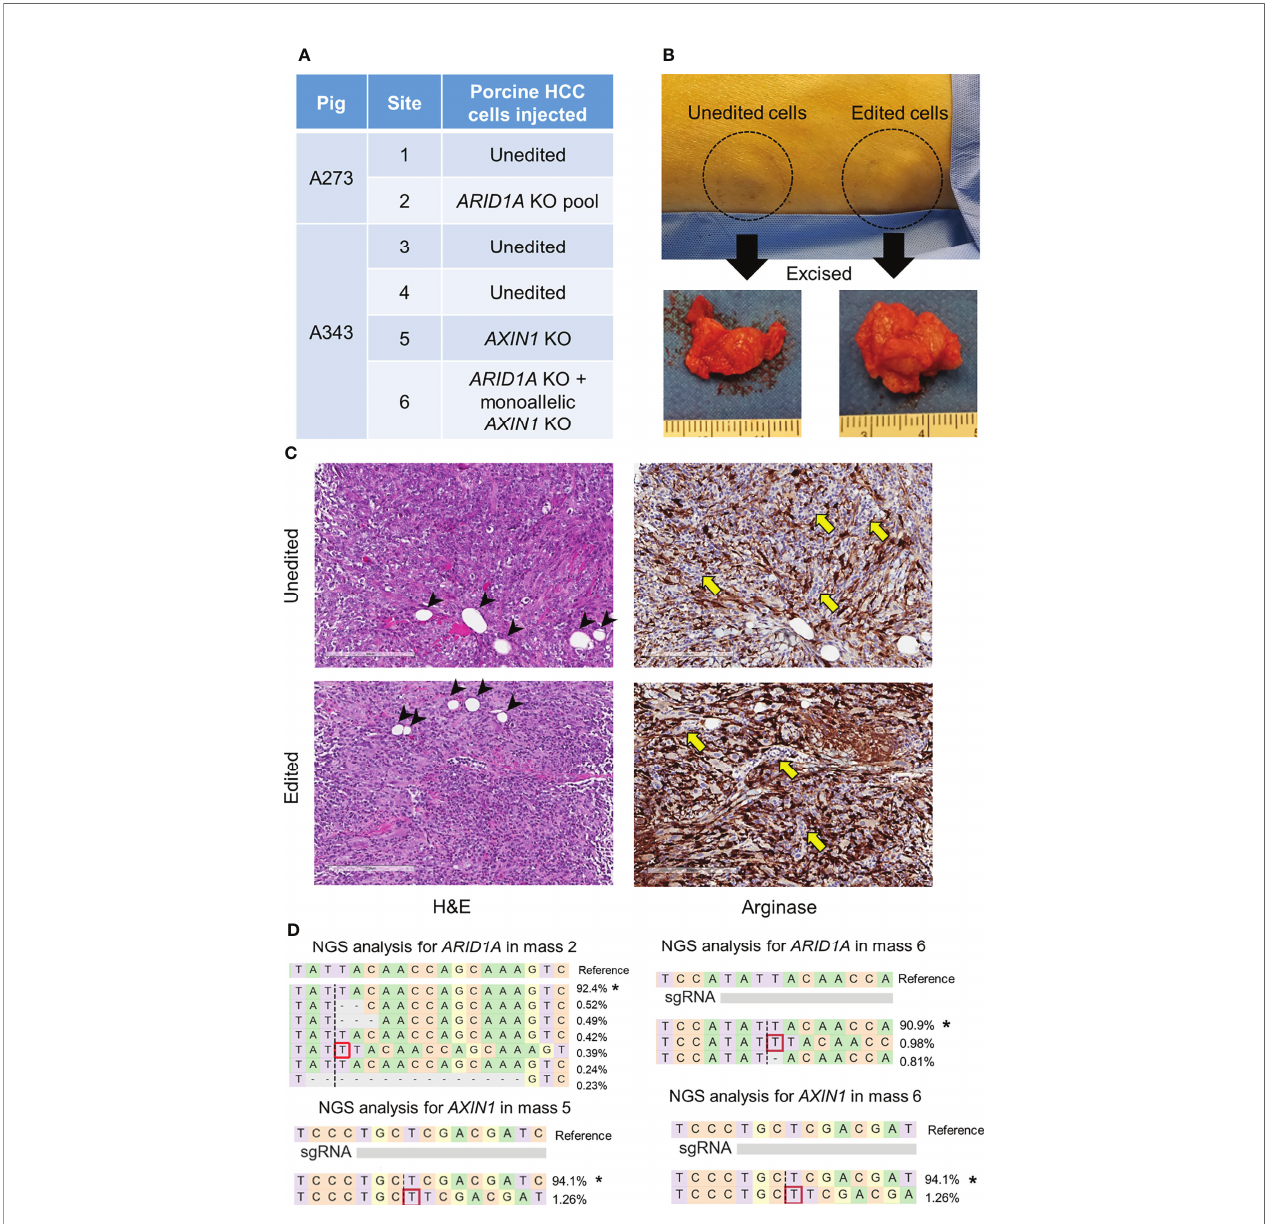
FIGURE 8 | Development of subcutaneous masses harboring CRISPR-induced ARID1A and/or AXIN1 edits in pigs. (A) Autologous unedited or CRISPR-edited porcine HCC cells were injected into distinct subcutaneous sites in 2 Oncopigs as presented in the table. (B) Representative image of two subcutaneous masses developed in pig fl ank 11 days post-injection of unedited or CRISPR-edited porcine HCC cells, at which point the masses were excised. (C) Representative microscopy images of H&E and Arginase staining of subcutaneous masses developed by injection of unedited or CRISPR-edited cells. The images show Arginase- stained porcine HCC cells (brown staining) surrounded by in fl ammatory cells (yellow arrows) and fat cells (arrow heads). Scale bar, 200 m m. (D) Reads detected by targeted NGS analysis in the three CRISPR-edited subcutaneous masses mapped to the reference sequences. The percentage of reads of each sequence are shown on the right. The asterisk (*) indicates/marks non-edited reads. Dashed line, predicted Cas9 cleavage position; red box, insertion; dash, deleted